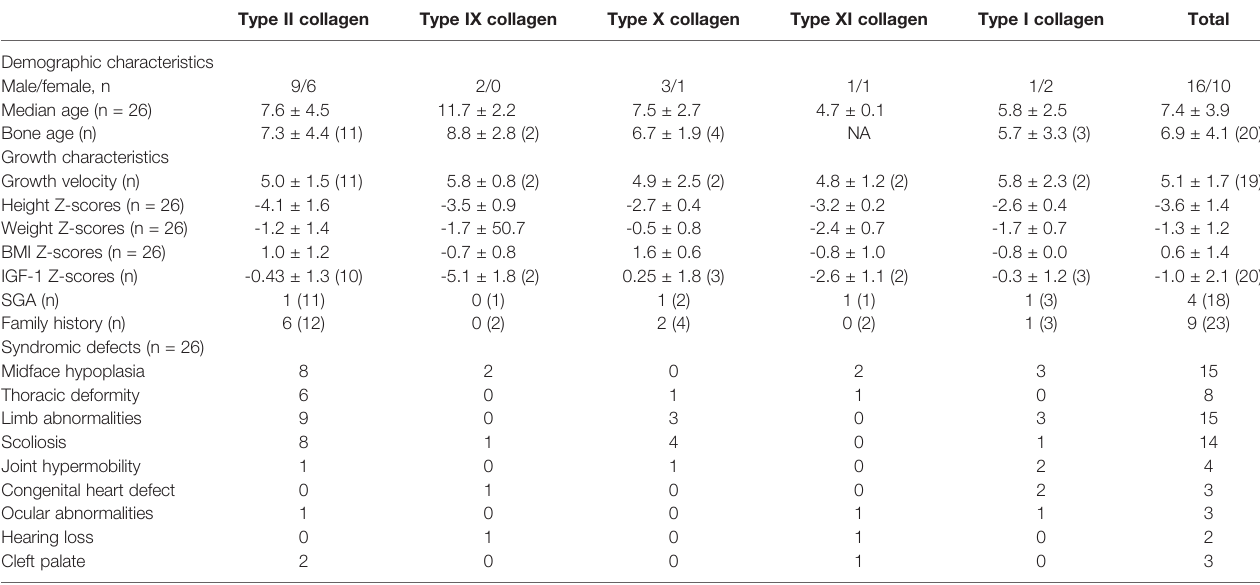
TABLE 2 | Baseline characteristics of individuals with skeletal